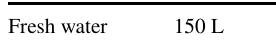
Table 1 Water-based mud formulation